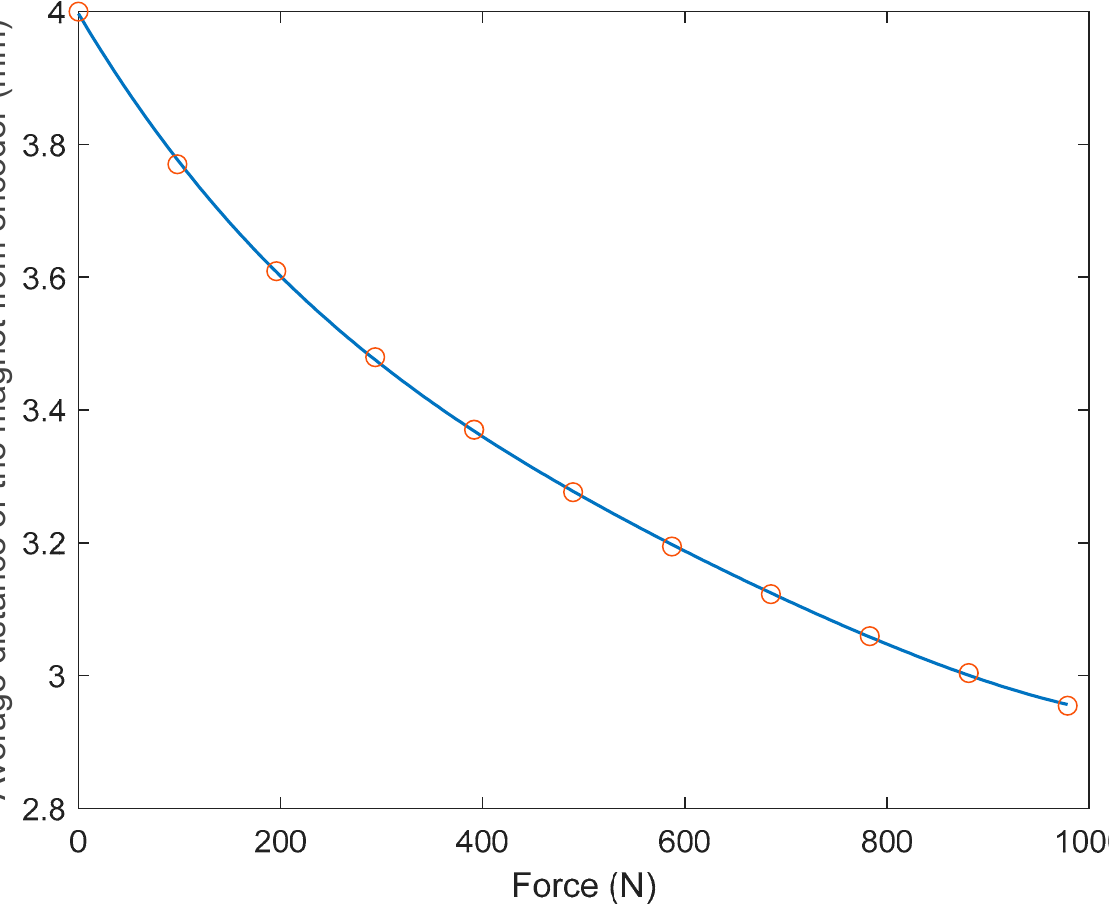
Figure 12. The change of relative distance between the magnet and the magnetic field transducer with respect to the change of axial force and their 4 th -order polynomial fitting.